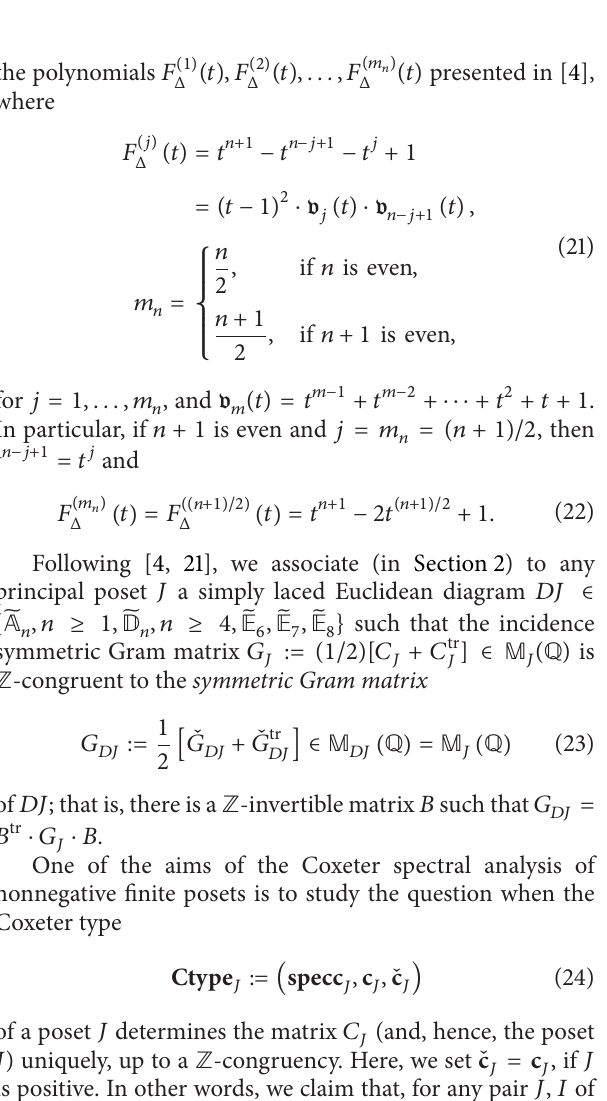
Figure 1: Simply laced Euclidean (extended Dynkin)